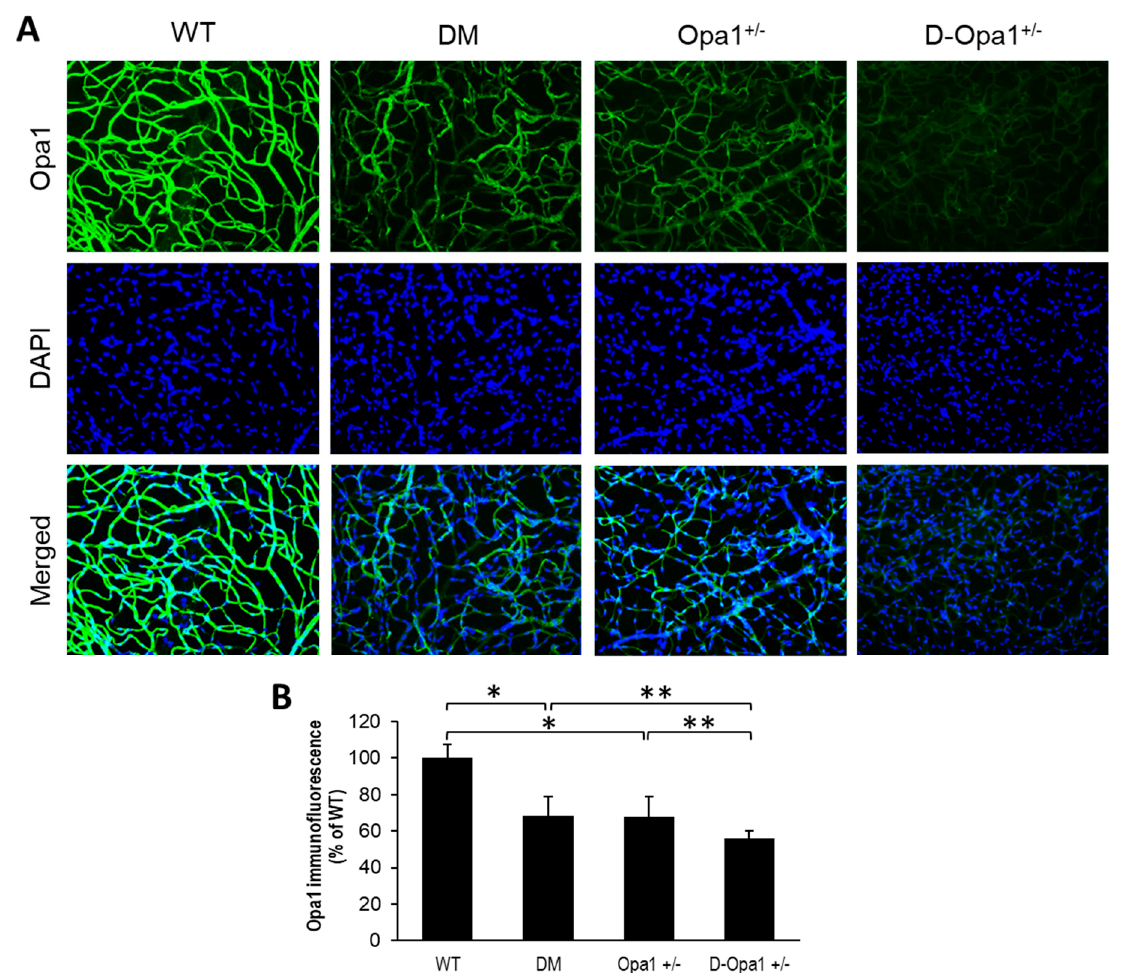
Figure 2. Opa1 +/ − mice exhibit reduced Opa1 immunofluorescence in the retinal capillary network. ( A ) Representative images of Opa1 immunofluorescence (green) and DAPI (blue) in retinal capillaries of wild type (WT) mice and Opa1 +/ − mice; 20x magnification. ( B ) Graphical illustration of cumulative data shows decreased Opa1 immunofluorescence in retinal capillaries of Opa1 +/ − mice compared with that of WT mice. * p < 0.01, n = 6; ** p < 0.05, n = 6.